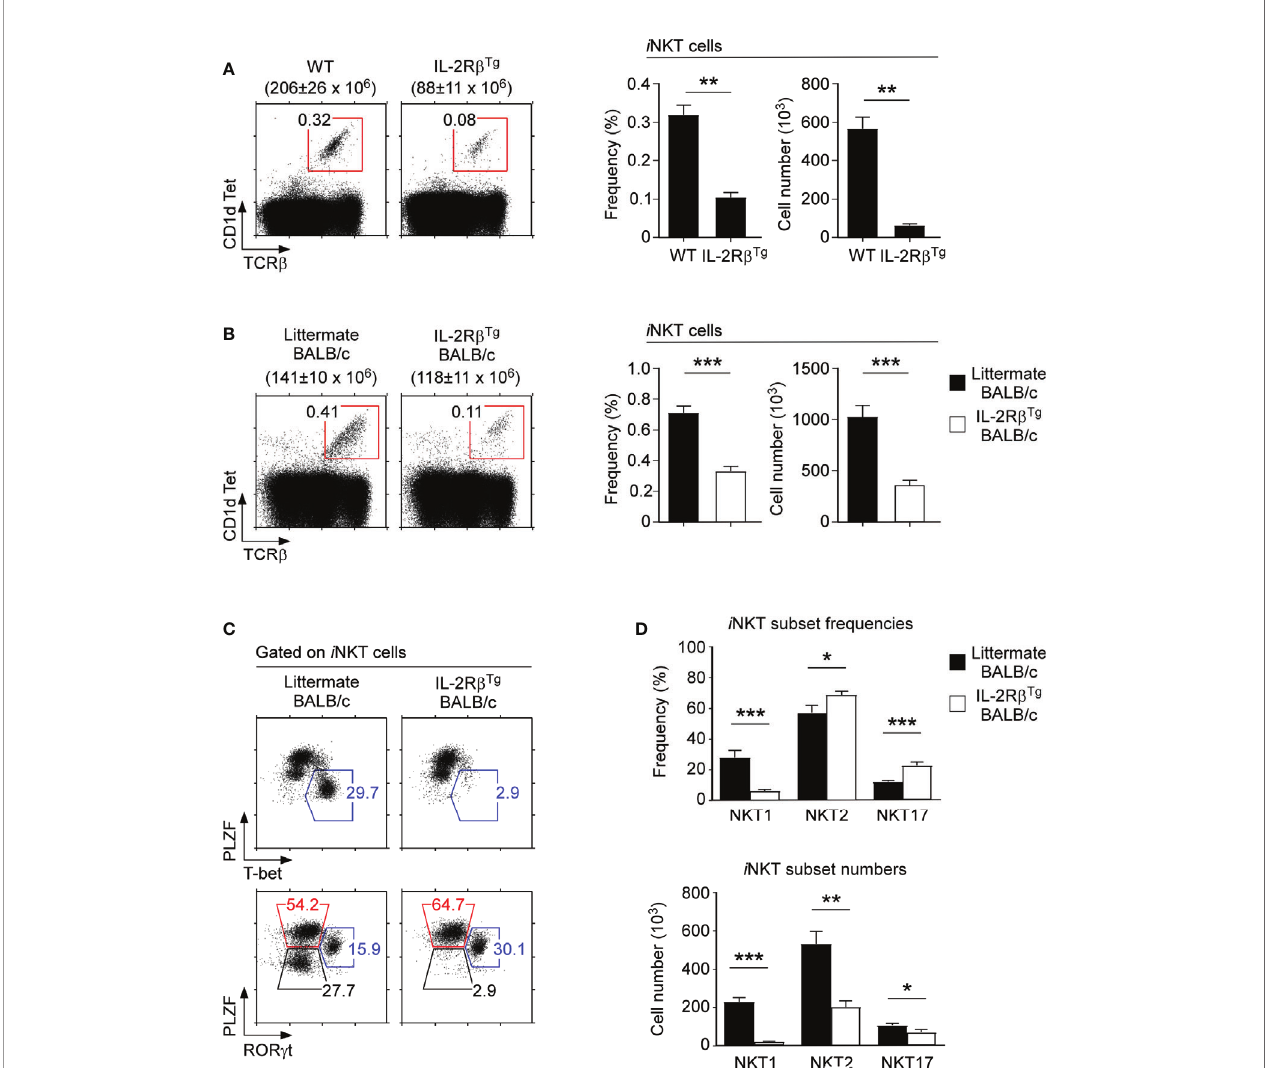
FIGURE 4 | i NKT cell differentiation in IL-2R b transgenic mice (A) Frequency and number of thymic i NKT cells in IL-2R b Tg and littermate C57BL/6 mice. The dot plots show thymic i NKT cells as identi fi ed by CD1dTet versus TCR b staining (left). The total thymocyte numbers are shown above the dot plots as the means ± SEM. The bar graphs show the frequencies and numbers of i NKT cells from the indicated mice (right). The dot plot is representative, and the bar graphs are a summary of 4 independent experiments with a total of 7 IL-2R b Tg and 6 littermate C57BL/6 mice. (B) Frequency and number of thymic i NKT cells in IL-2R b Tg BALB/c and littermate WT mice. The dot plots show thymic i NKT cells as identi fi ed by CD1dTet versus TCR b staining (left). The total thymocyte numbers are shown above the dot plots as the means ± SEM. The bar graphs show the frequencies and numbers of i NKT cells from the indicated mice (right). The dot plot is representative, and the bar graphs are a summary of 3 independent experiments with a total of 7 IL-2R b Tg and 8 littermate WT mice. (C) The dot plots show the thymic i NKT subset composition in IL-2R b Tg BALB/c and WT littermate mice based on PLZF versus T-bet (top) and PLZF versus ROR g t analysis (bottom). Results are representative of 4 independent experiments. (D) The bar graphs show the summary of thymic i NKT subset distribution for the indicated mice. Subset frequencies are the summary of 5 independent experiments with a total of 10 IL-2R b Tg and 10 littermate WT BALB/c mice (top). Cell numbers of each i NKT subset are the summary of 4 independent experiments with a total of 8 IL-2R b Tg and 7 littermate WT BALB/c control mice (bottom). *P < 0.05; **P < 0.01; ***P <